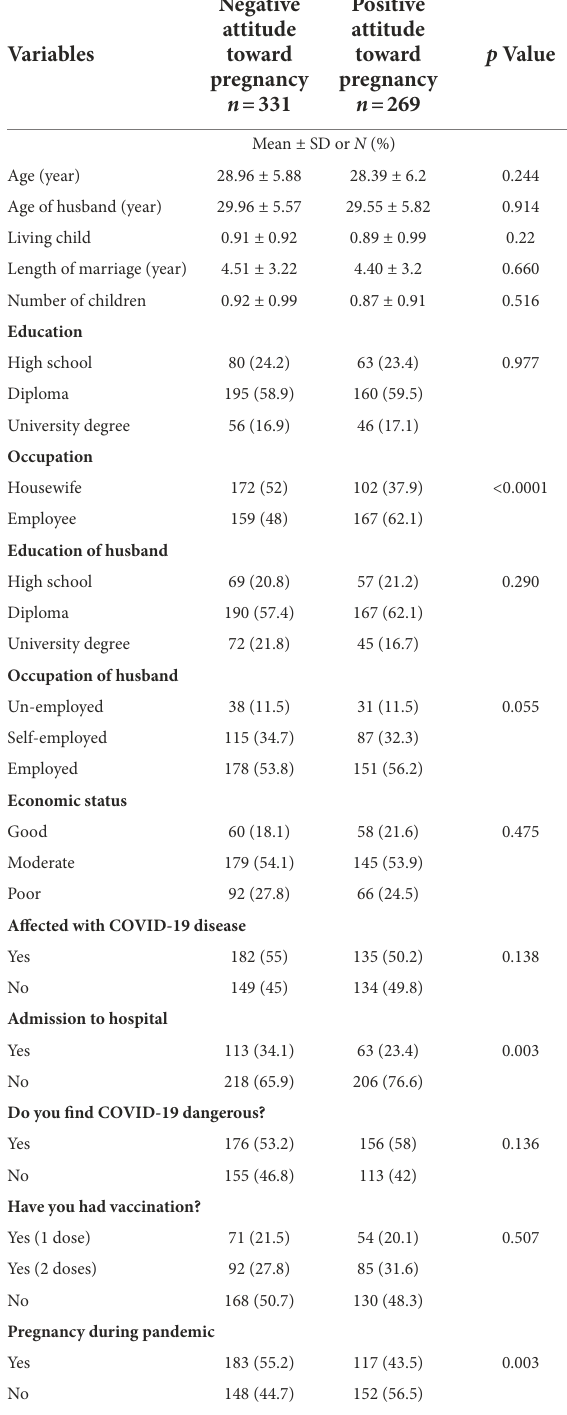
TABLE 1 Demographic characteristics of two groups with positive and negative attitudes toward pregnancy and